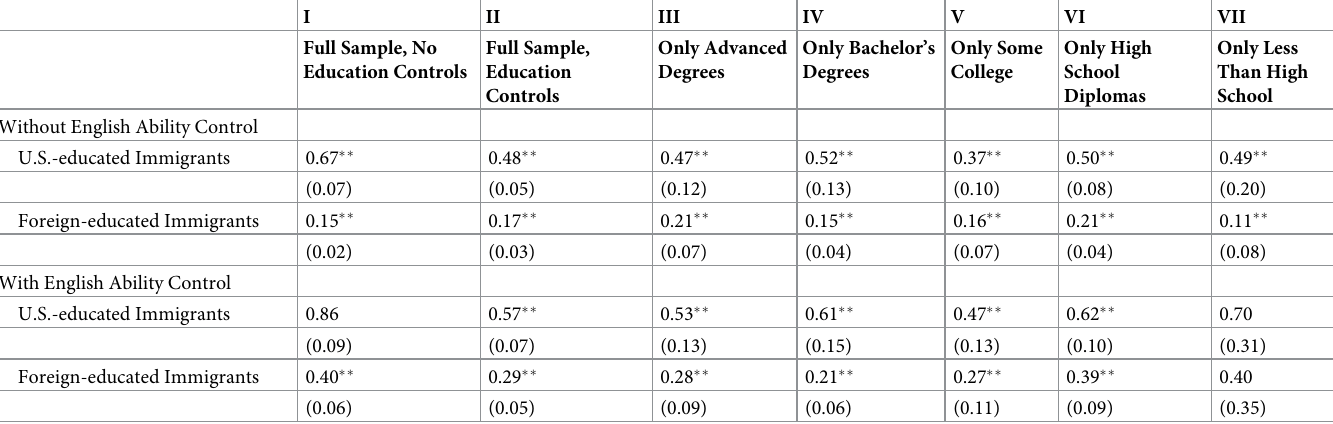
Table 5. Immigrant-native differences in PIAAC PST scores.